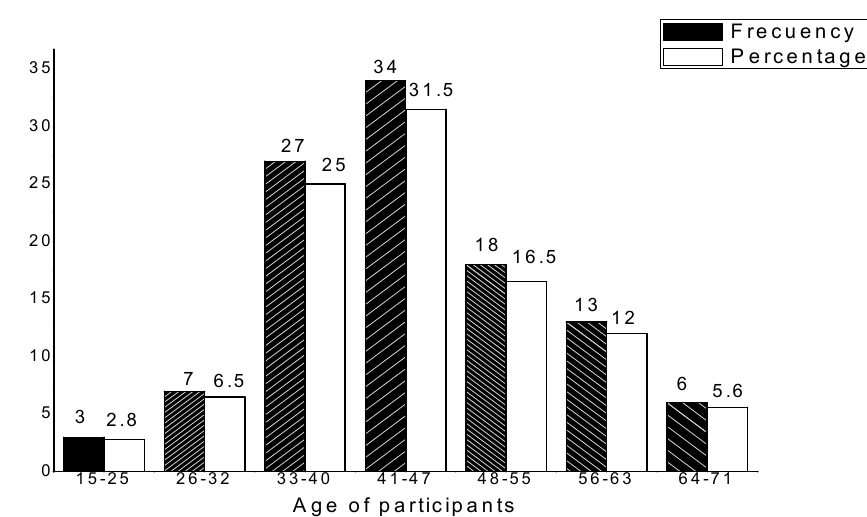
Figure 4. Aquaculture producers surveyed in Mexico. Age of participants (2019).